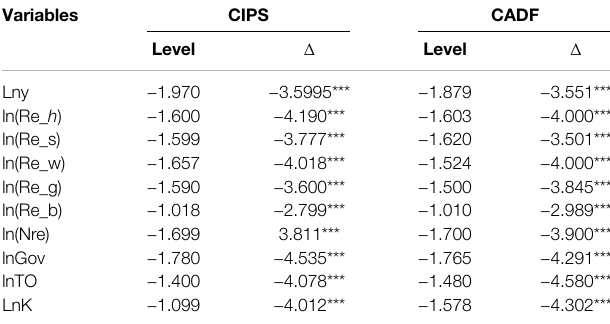
TABLE 3 | The panel stationary properties ’ outcomes.